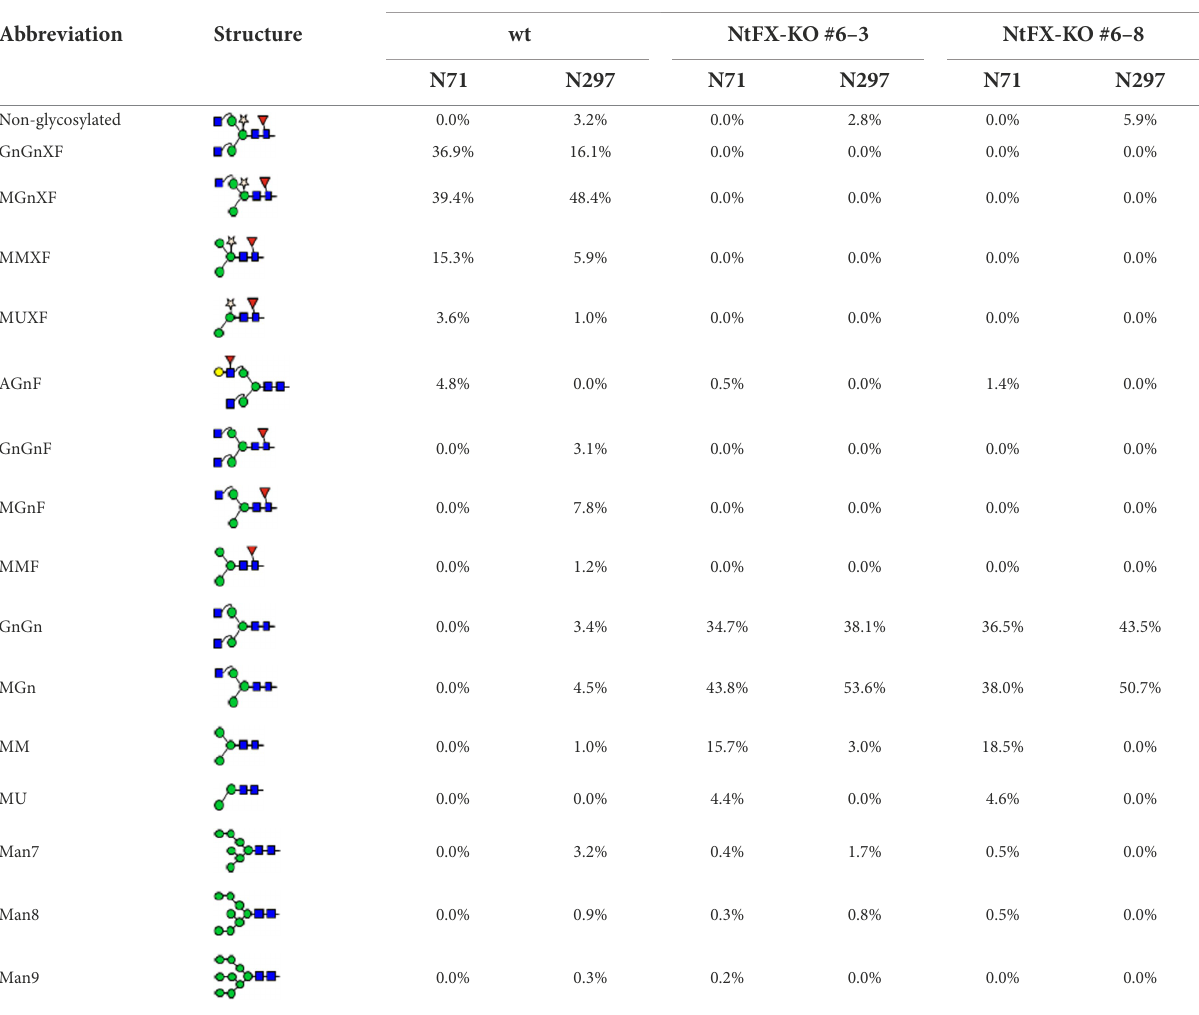
TABLE 1 Quantification of the relative abundance of N -glycans detected on the light (N71) and heavy chains (N297) of VRC01 hIgG1 produced in Nicotiana tabacum cv. SR-1 wild-type and NtFX-KO lines.